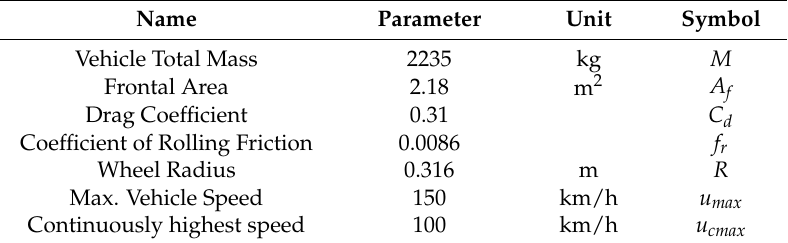
Table 2. Vehicle specification parameters.